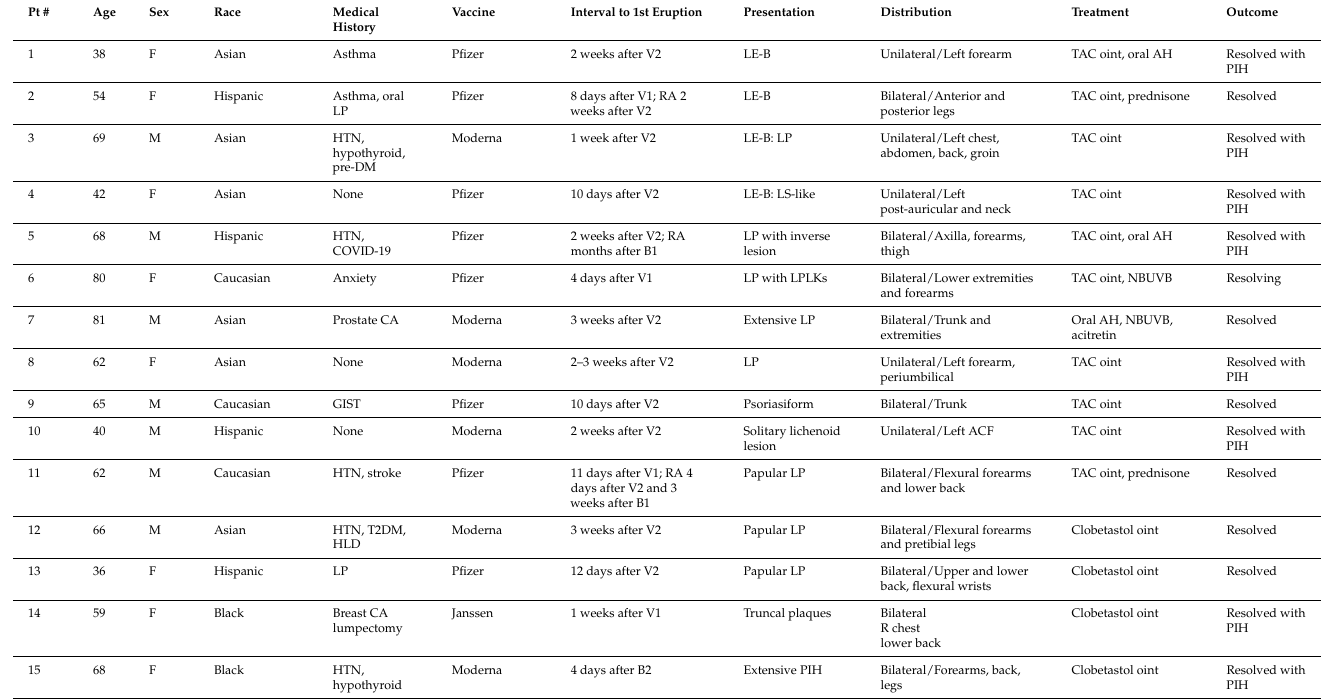
Figure 13. COVID-19 vaccine-induced lichenoid eruptions—case series of 15 patients. Shown on the x-axis are atypical features of the dermal infiltrate. Table 1. Vaccine-induced lichenoid eruption (V-ILE) following COVID-19 vaccination—demographics and clinical characteristics of fifteen patients from a case